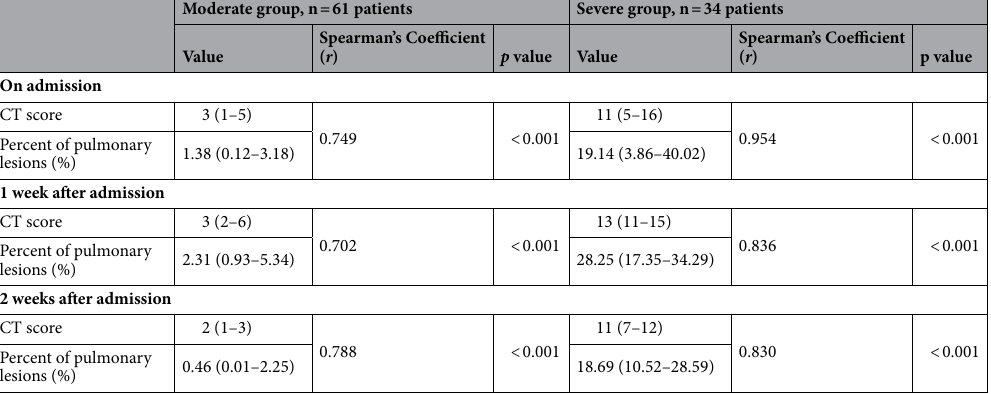
Table 5. Correlation at different time points in moderate and severe